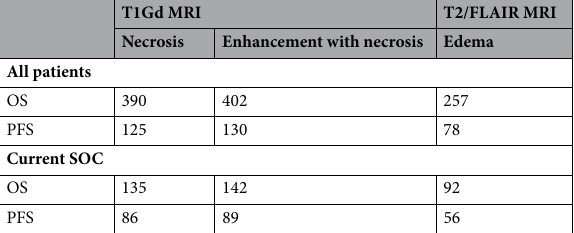
Table 1. Cohort of patients with known overall survival (OS) and progression free survival (PFS). This table shows the number of patients with available imaging ROIs and known OS and PFS, including the subsets known to have received the current standard of care (SOC). The discrepancy between patients with available necrosis ROIs and T1Gd enhancing ROIs is due to 12 patients with negligible necrosis that precluded addition of those tumors to the necrosis-specific